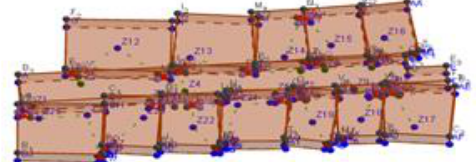
Figure 6: 3D building modelling of room 9 by Trimble LaserAce 1000 where dash lines represent measured data from Trimble LaserAce 1000 and solid lines represent extruded floor plan.